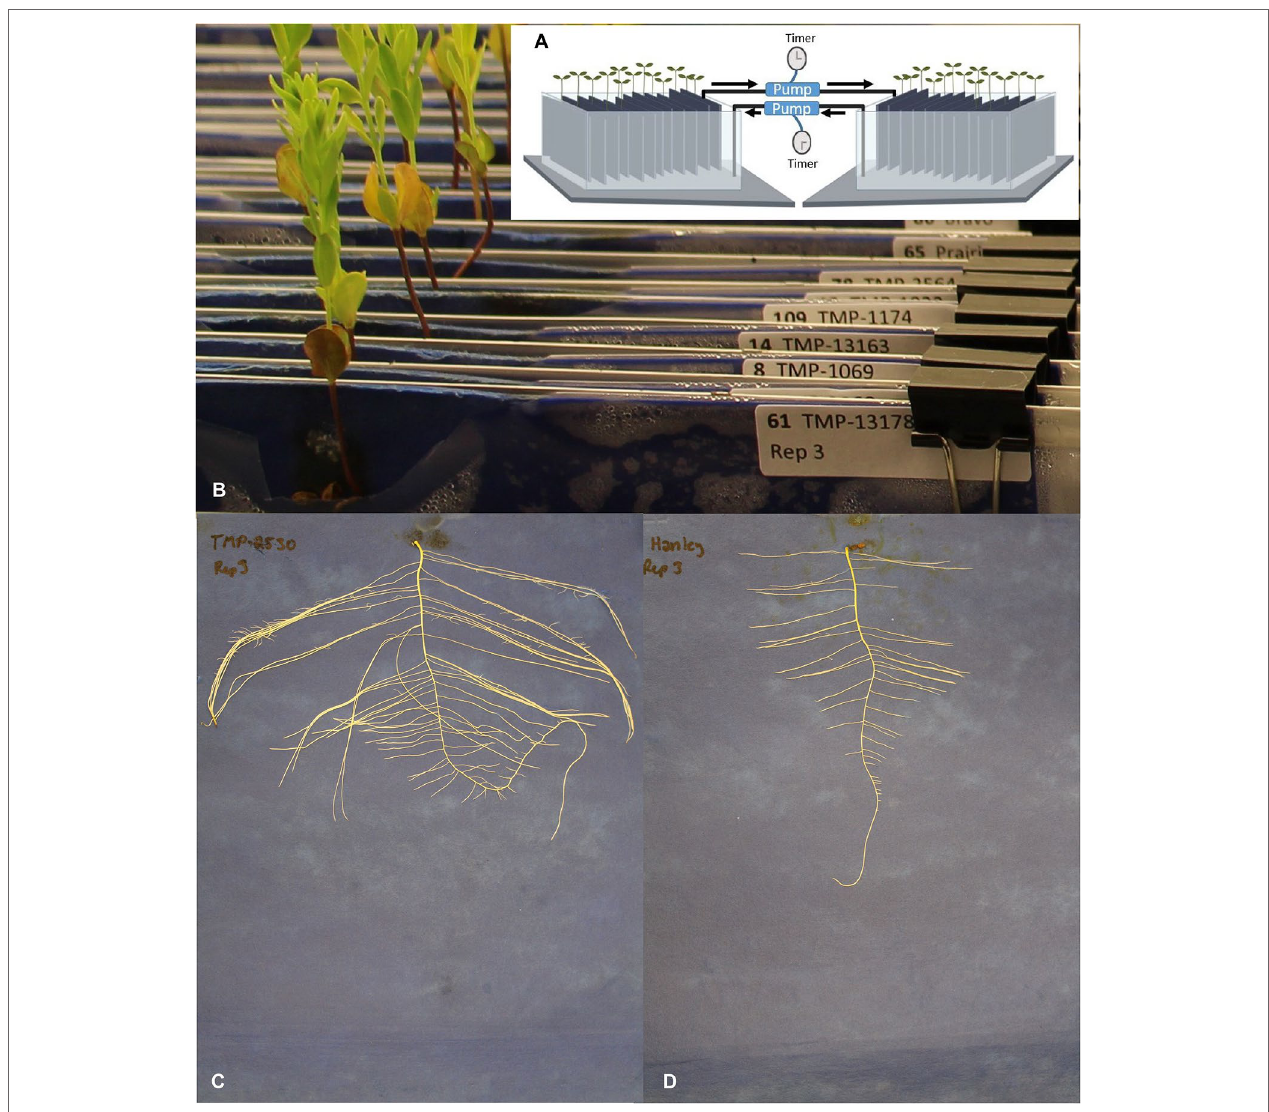
FIGURE 1 | Early root phenotyping experiment set-up and representative root images. (A) Diagrammatic sketch of the phenotyping system, arrows show the water flow direction, (B) close-up of the experimental set-up showing a partial view of the upper section of the blotting papers, labels, and plantlets, (C) extensive root system of TMP-2530 (U_MAR_C_CN98193), and (D) root system of flax cultivar